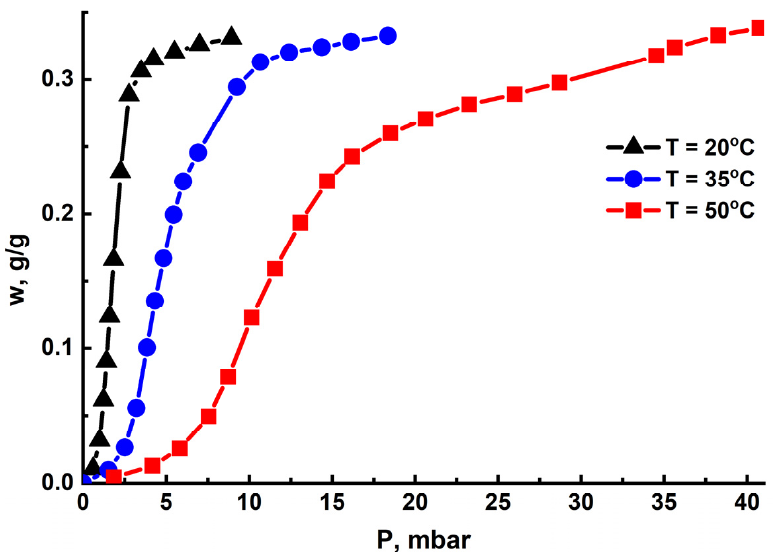
Figure 4. Isotherms of water adsorption on the MIL-160 at T = 50 °C (red), 35 °C (blue), and 20 °C (black).